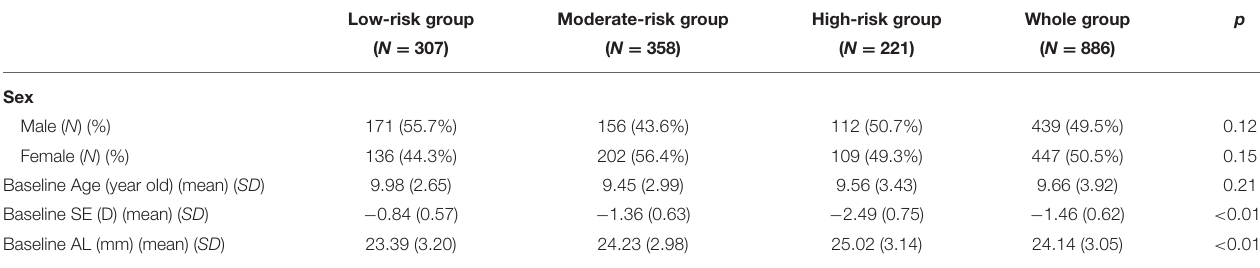
TABLE 2 | Demographic characteristics of enrolled children in the second part of the study. Low-risk group Moderate-risk group High-risk group